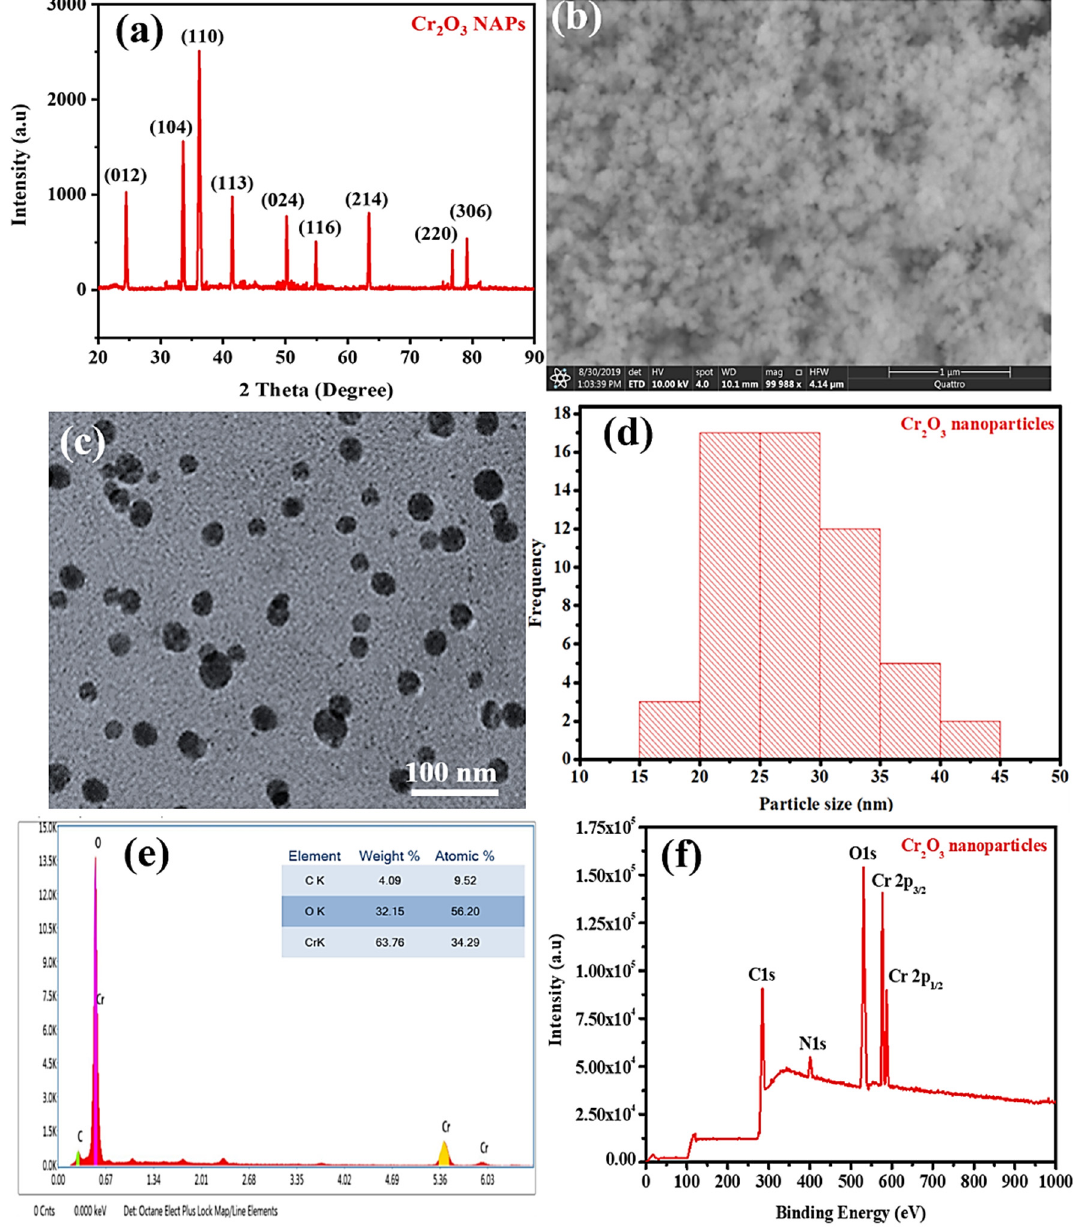
Figure 3. ( a ) XRD, ( b ) SEM, scale bar = 1 µm, ( c ) TEM, ( d ) DLS particle size distribution, ( e ) EDX and ( f ) XPS analysis of green synthesized Cr 2 O 3 nanoparticles .